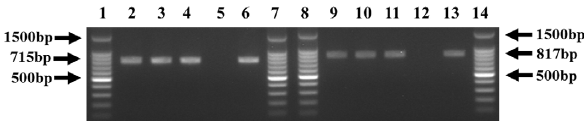
Figure 2. PCR amplification of the mitochondrial gene fragments from Kudoa septempunctata spores (in triplicate). Lanes: 1; SiZer TM -100 bp DNA Marker (iNtRON, Korea), 2–4; cox 1 gene, 5; negative control, 6; positive control, 7; Size marker, 8; Size marker, 9–11; rnl gene, 12; negative control, 13; positive control, 14; Size